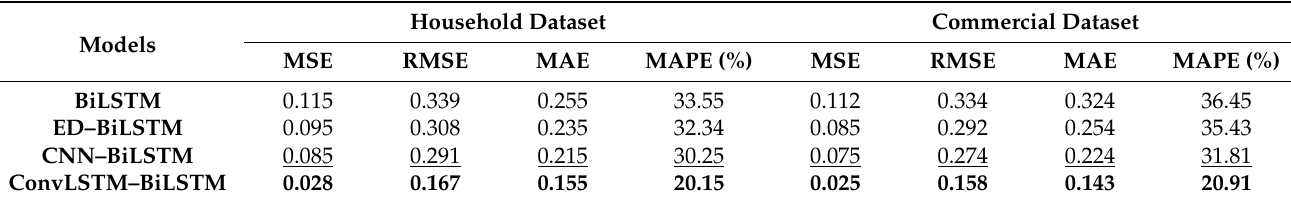
Table 6. Performance of the proposed models on the weekly